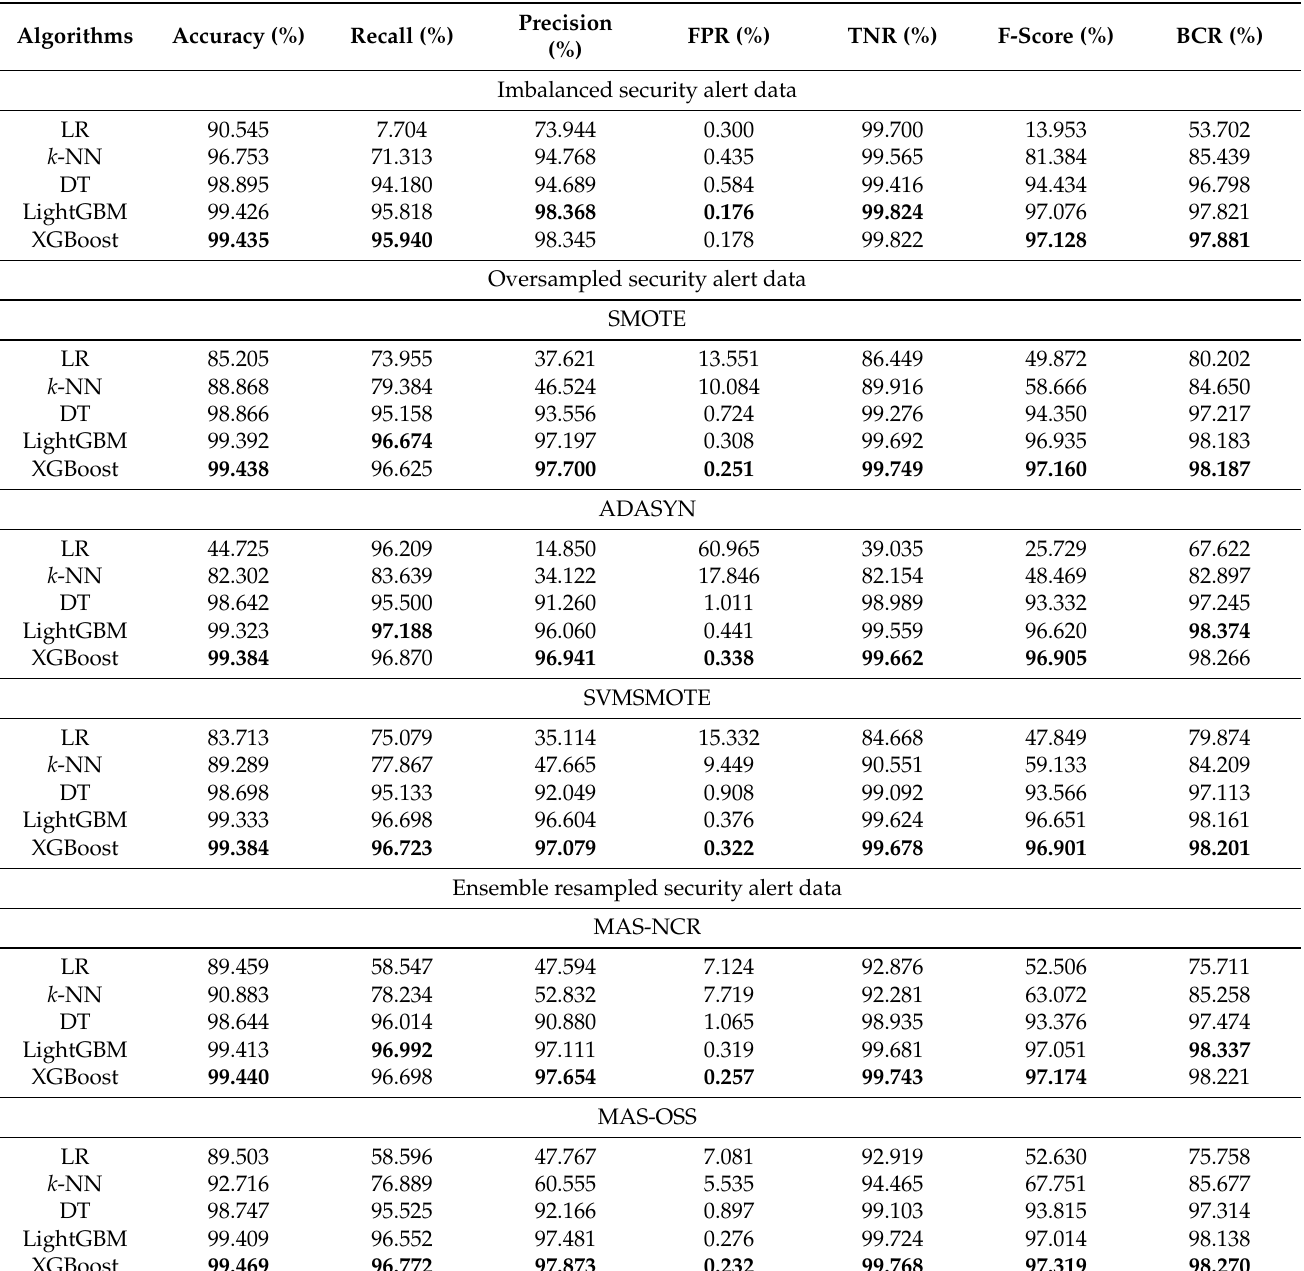
Table 5. Performance evaluation with different sampling settings on the UNSW-NB15